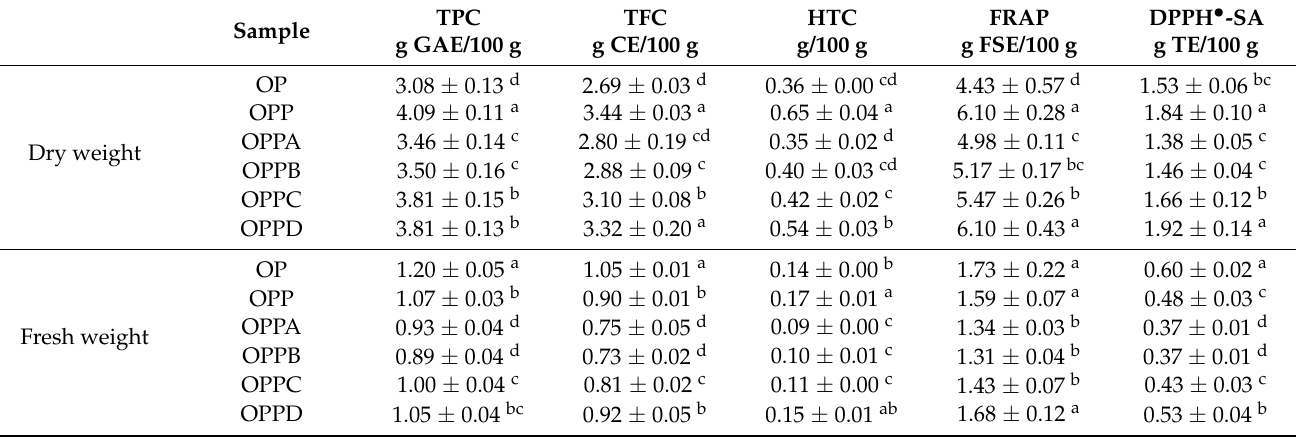
Table 4. Phytochemicals contents and antioxidant activity of olive pomace